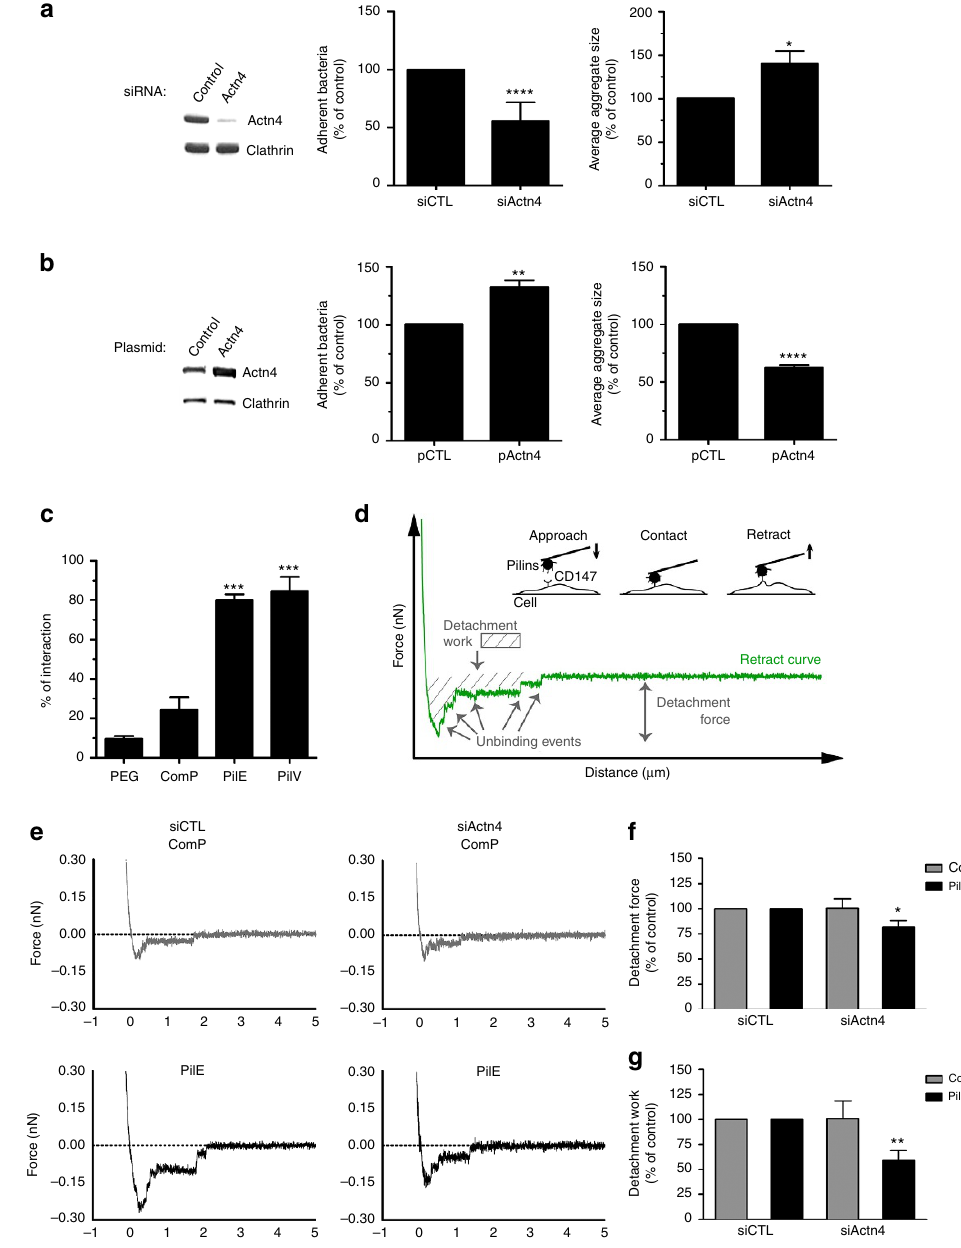
Figure 8 | a -Actn4 regulates the strength of meningococcal adhesion to human endothelial cells. ( a and b ) Actn4 expression modulates bacterial adhesion to human endothelial cells under shear stress. HBMECs were transfected with ( a ) control (CTL) or Actn4 siRNA or with ( b ) control (CTL) or Actn4 plasmid. Right panels: Western blot analysis of Actn4 levels, using clathrin as a control. Middle panels: Number of adhesion events (meningococci adhering individually or in aggregates) following a 10min infection under shear stress (0.04dynescm (cid:3) 2 ). Left panels: Average size (in pixels) of the meningococcal colony. The number and the size of the adherent individual bacteria and/or bacterial aggregates were quantified using the ImageJ software. Representative images of the adherent bacteria in each condition are shown in Supplementary Fig. 10. Mean ± s.e.m., n ¼ 4, **** P o 0.0001, ** P o 0.01, * P o 0.05, two-tailed Student’s t -test. ( c ) The meningococcal pilin PilE and PilV selectively interact with the endothelial cell surface. AFM analysis of retraction forces between cantilever tips functionalized with PEG linker alone (control) or with PEG linker plus MBP-pilins (ComP, PilE or PilV) and the apical membrane of living HBMECs. Bar plots indicate the percentage of force curves with unbinding events. Mean ± s.e.m.; n ¼ 7 experiments (448 force curves and 7 cells per condition), *** P o 0.001, one-way analysis of variance (ANOVA). ( d – g ) Actn4 expression regulates interaction strength between meningococcal pilins and their endothelial receptors. ( d ) Schematic representation of the different parameters measured. The detachment force corresponds to the total rupture force of adhesive bonds involved during interaction of pilin-coated bead with the cell surface throughout a series of unbinding events, as measured by the jumps on the force–distance retraction curve. Detachment work represents the ‘work of deadhesion’ that contains both mechanical components inherent to the cell type and adhesive elements due to pilin–receptor complexes that break on retraction of the bead. ( e ) AFM analysis of the interaction between 2- m m-sized beads coated with ComP or PilE and living Actn4-depleted or control HBMECs. Shown are the ( f ) detachment forces and the ( g ) detachment work measured. Mean ± s.e.m.; n Z 6 experiments (270 force curves and 30 cells per condition), * P o 0.05, ** P o 0.01, one-way